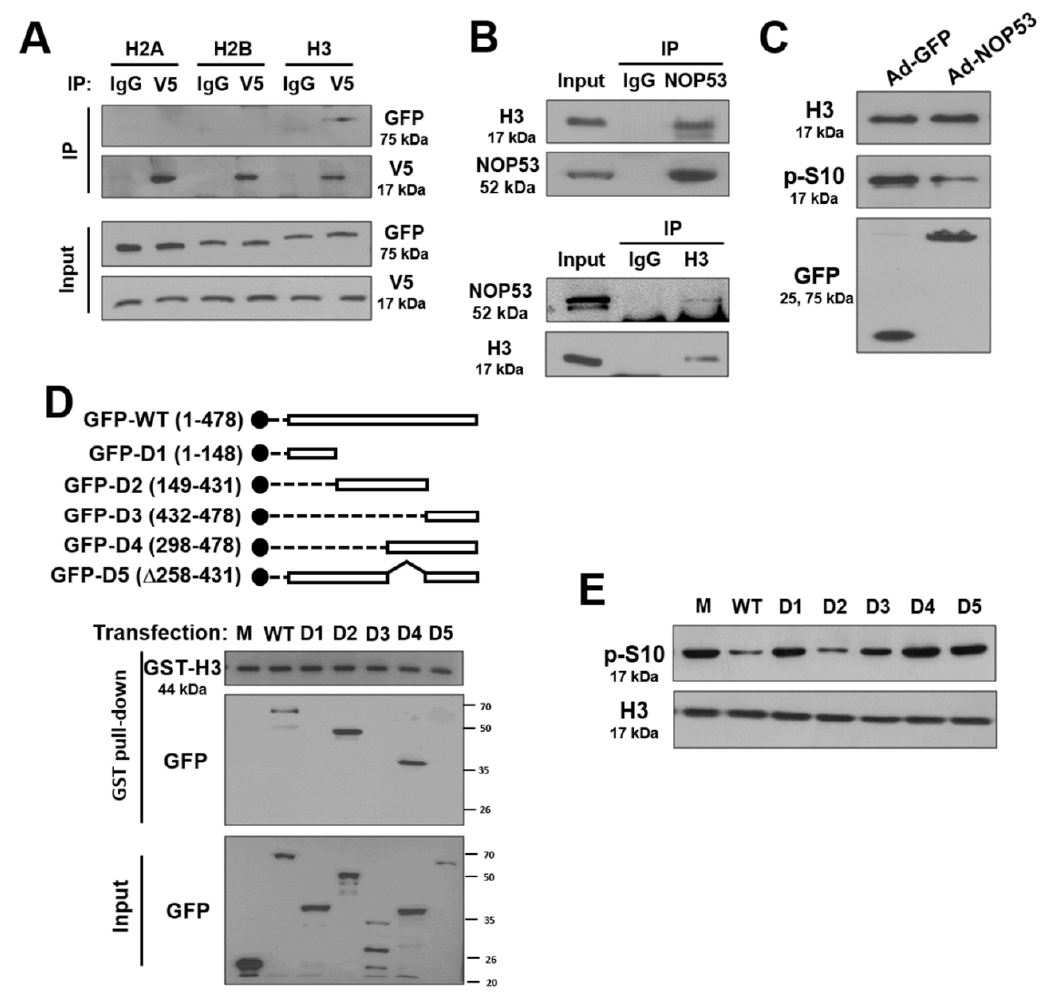
Figure 5. NOP53 interacts with histone H3. ( A ) Cells were co-transfected with V5-tagged NOP53-expressing plasmid and each set of GFP-tagged histone-expressing plasmids, as indicated (H2A, H2B, H3). Cell lysates were